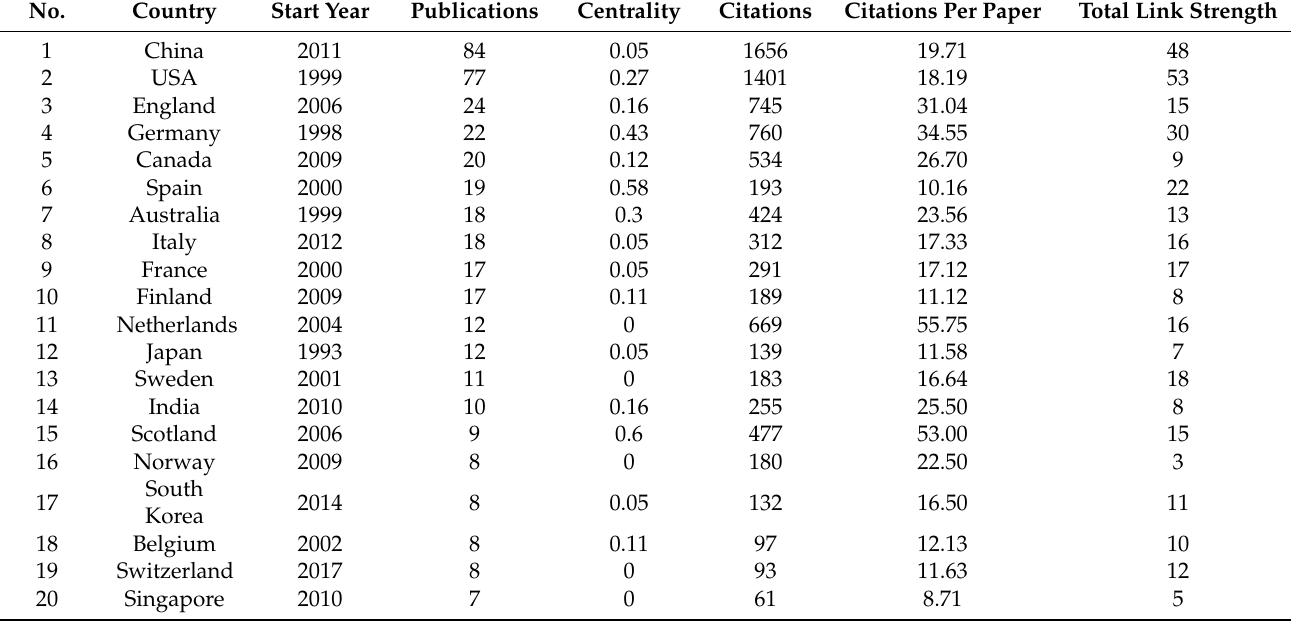
Table 4. Top 20 countries with the most publications on CPCN in buildings.